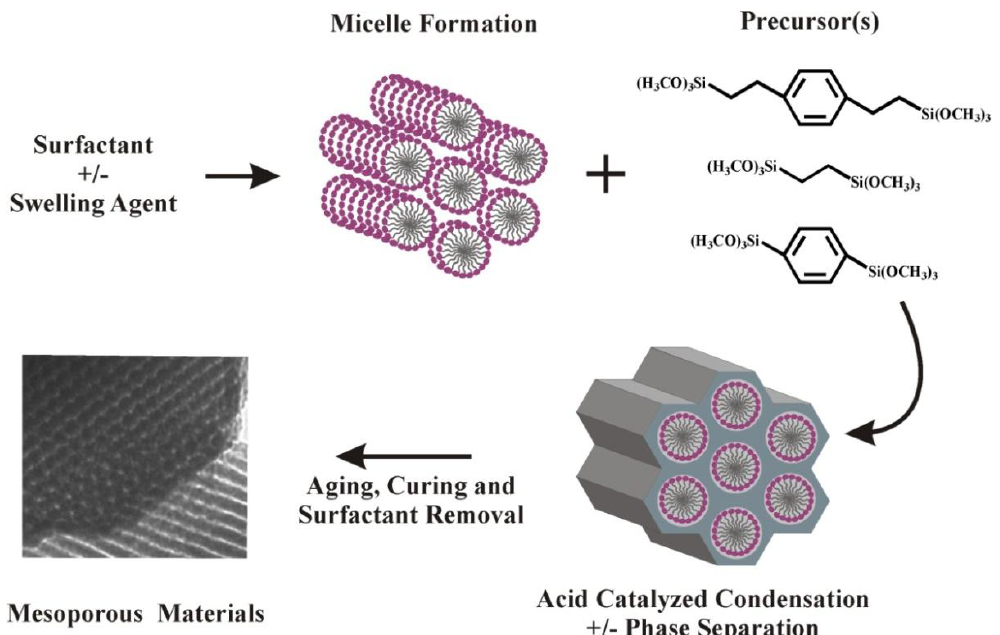
Figure 2. Synthesis of organosilicate